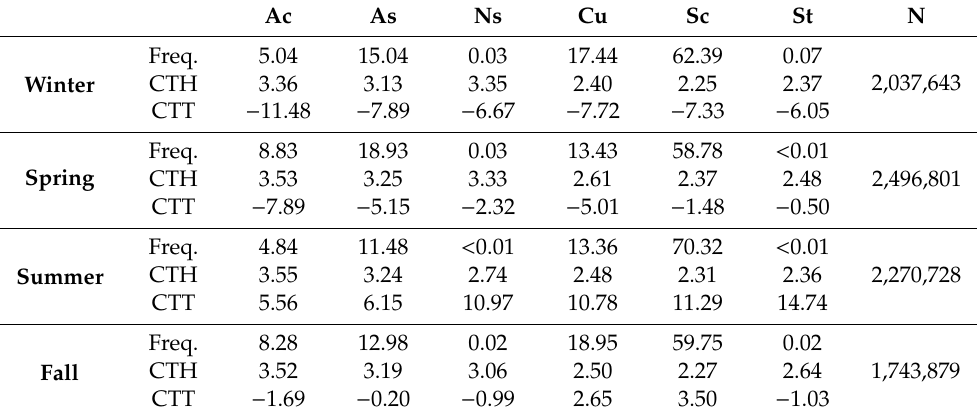
Table 1. Average seedable cloud occurrence frequency, cloud top height (CTH), and cloud top temperature (CTT) by season and seedable cloud type. Freq. denotes the occurrence frequency (%), CTH is in km, CTT is in ◦ C, and N is seasonal seedable cloud frequency according to the cloud phase. < 0.01 indicates a frequency of less than